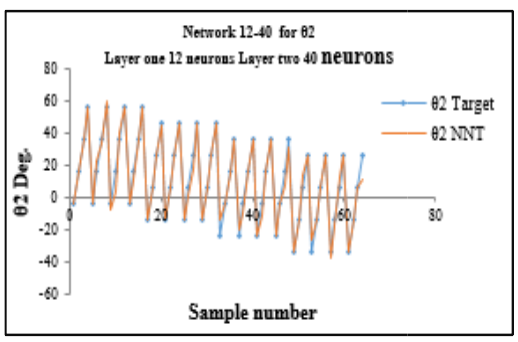
Fig. 20. θ 1 target Vs. θ 1 neural network two layers